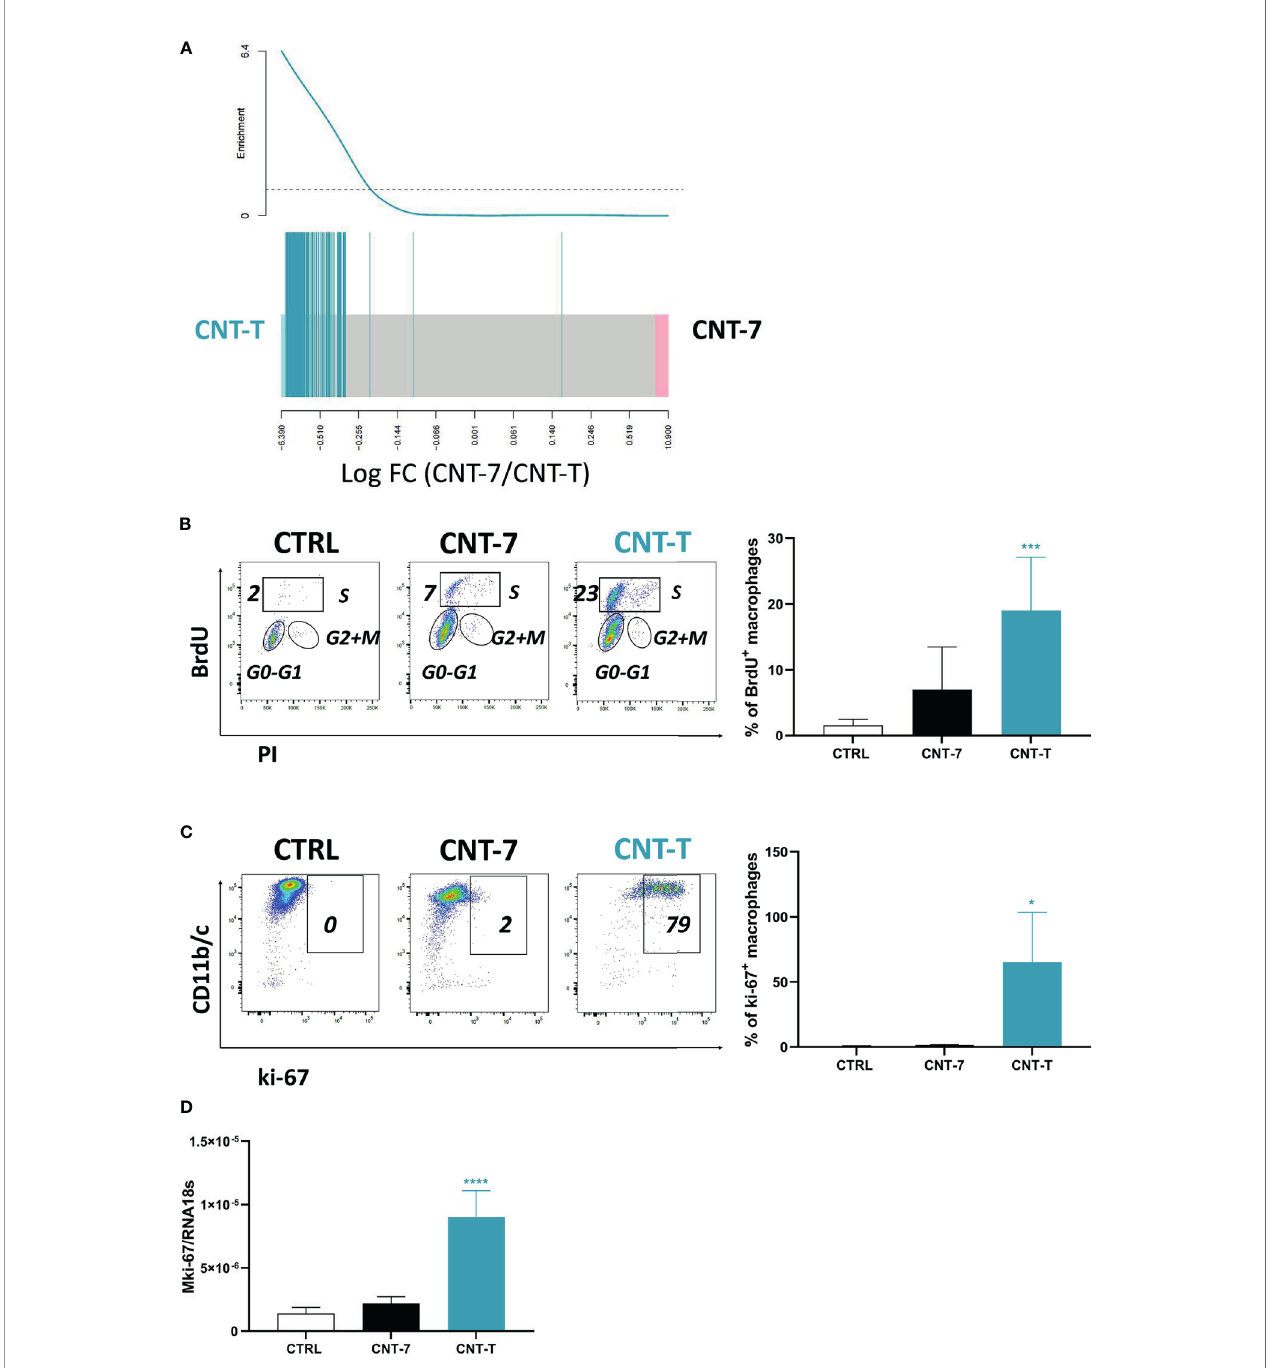
FIGURE 5 | Macrophages repopulating the peritoneal cavity after non-mesotheliomagenic CNT-T treatment are self-renewing. (A) Barcode plot showing enrichment of cell cycle related signature belonging to the “ Cell Cycle/Mitotic ” pathway R-RNO-69278 from Reactome database in the CNT-7 vs CNT-T macrophage comparison (respectively in black and green). Macrophages were puri fi ed from the rat peritoneal cavity after CNT-7 or CNT-T treatment (2 mg I.P.) at day 15. The worms show relative enrichment. (B) Flow cytometry dot plots show the proportions of peritoneal macrophages in S phase (BrdU-positive) of untreated Wistar rats or rats injected (2 mg I.P.) with CNT-7 or CNT-T and sacri fi ced at 7 days. Graph of BrdU-positive macrophages: each bar represents mean ± SD of 6 observations. (C) Flow cytometry dot plots show the proportions of peritoneal macrophages ki-67-positive from untreated or CNT-7/CNT-T treated rats sacri fi ced at 7 days. The graph represents the ki-67-positive macrophages from untreated rats and CNT-7 or CNT-T-treated rats. Each bar represents mean ± SD of 6 observations. (D) mki- 67 from macrophages puri fi ed from untreated and CNT-treated rats (at 15 days) was quanti fi ed by qRT-PCR. Values are means ± SD of 4 animals. The results were statistically analysed using ANOVA test followed by Dunnett ’ s test. (*) p = 0.0332, (***) p = 0.0002, (****) p < 0.0001 indicates a statistically signi fi cant difference with